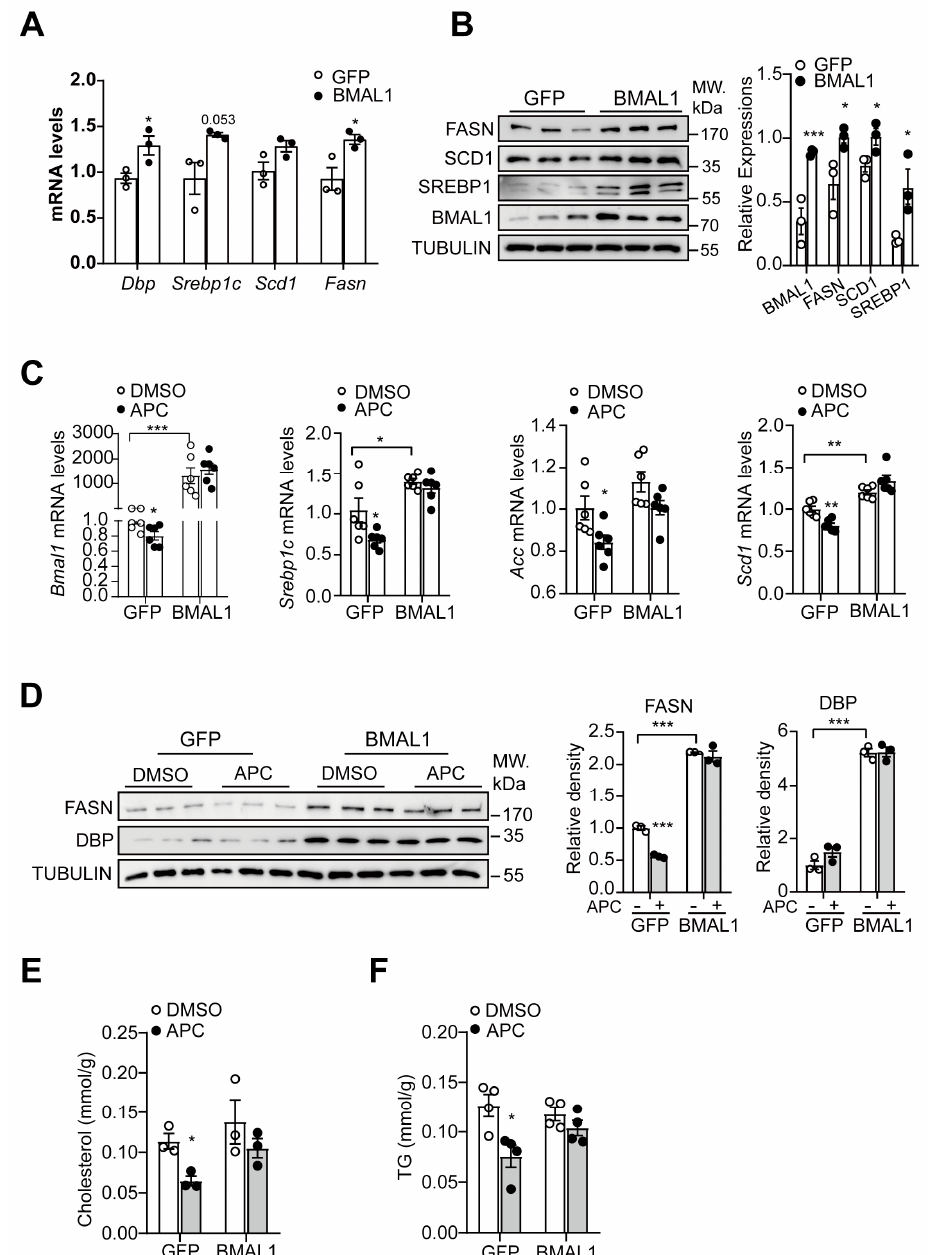
Figure 6. APC inhibits lipid synthesis with an effect dependent on BMAL1: ( A ) mRNA levels of Dbp (D site − binding protein), Srebp1c , Scd1 , and Fasn analyzed by real − time qPCR in primary hepatocytes. The cells were infected with GFP − and BMAL1 − expressing adenovirus for 24 h ( n = 3 per group); ( B ) Western blots of BMAL1, SREBP1, SCD1, and FASN proteins in primary hepatocytes; the cells were treated as before ( n = 3 per group); ( C ) mRNA levels of Bmal1 , Srebp1c , Acc , and Scd1 analyzed